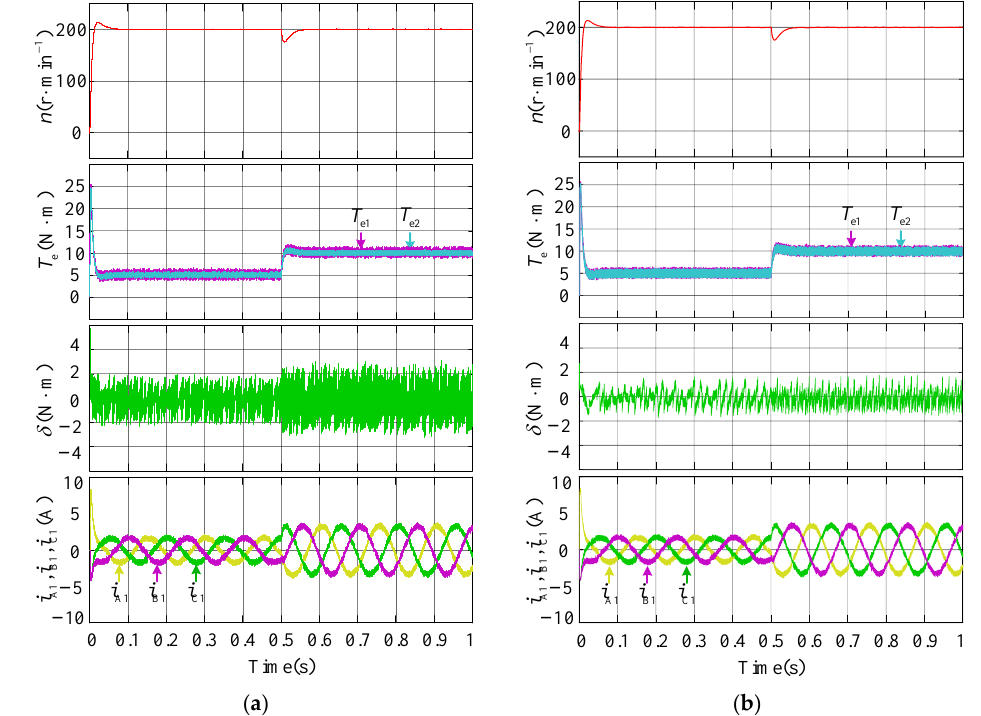
Figure 7. Simulation results for step change of load torque: ( a ) the closed-loop control strategy and ( b ) the proposed FCS-MPC strategy. (3) The initial total load torque is 10N·m, and the load torque disturbance with a magnitude of 10N·m and a duration of 0.01s is suddenly added at 0.5s. The comparison of the simulation results under the two control strategies is shown in Figure 8.